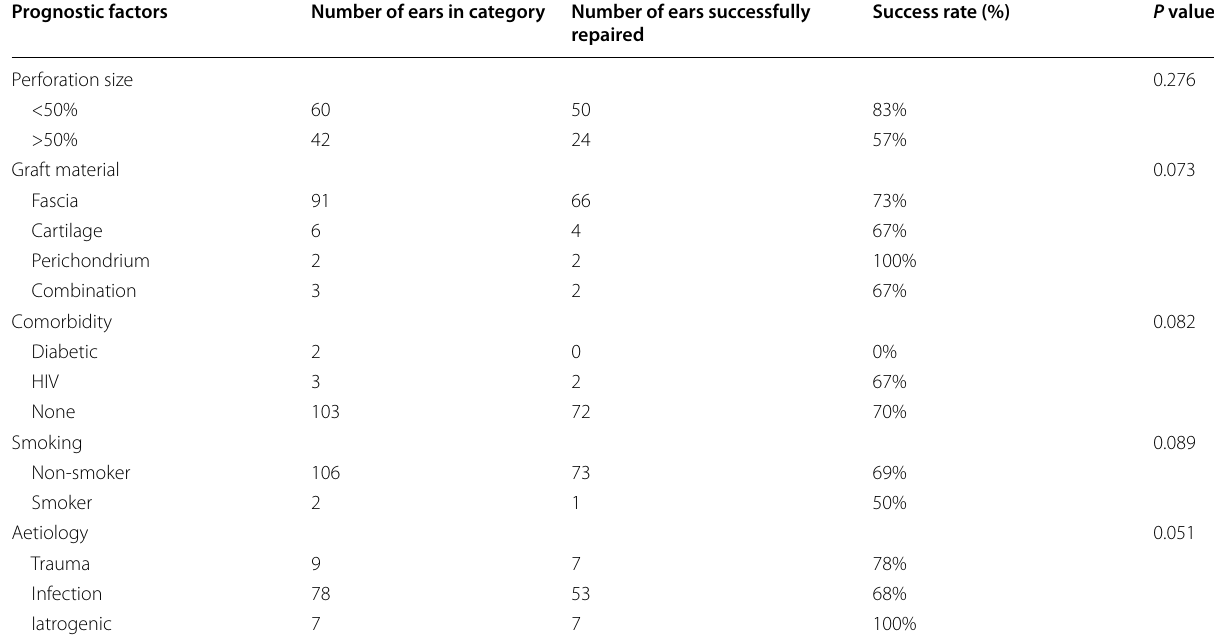
Table 2 Success prognostic factors in the current study: factors with no significance Prognostic factors